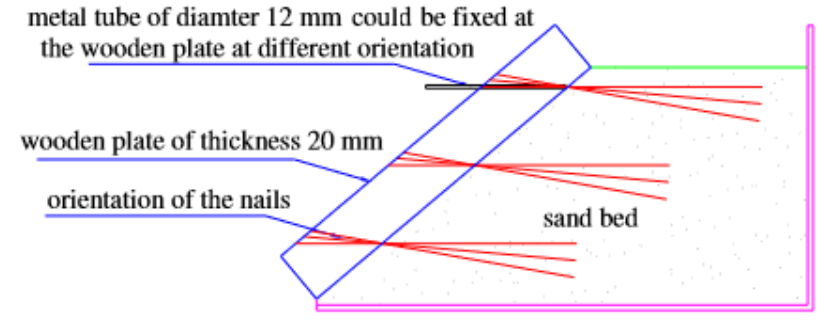
Figure 3. Construction of the inclined nail.